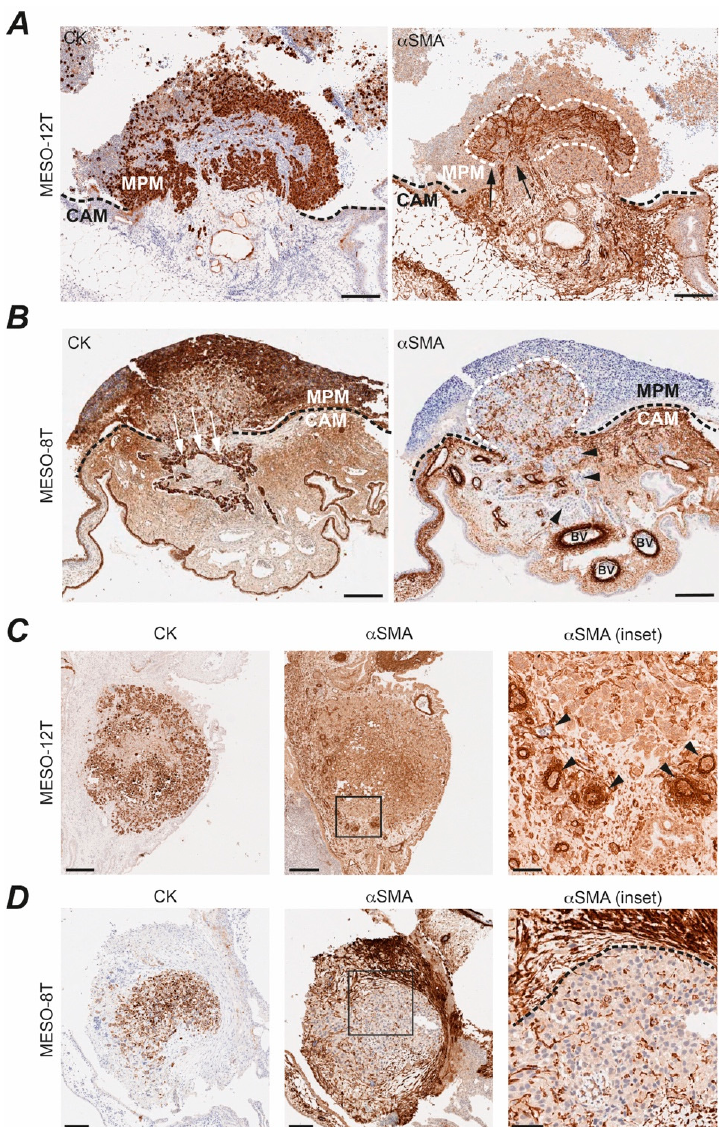
of both the metastasis-associated matrix metallopeptidase MMP9 , and the growth factor VEGF that induces proliferation and migration of vascular endothelial cells (Figure 6).